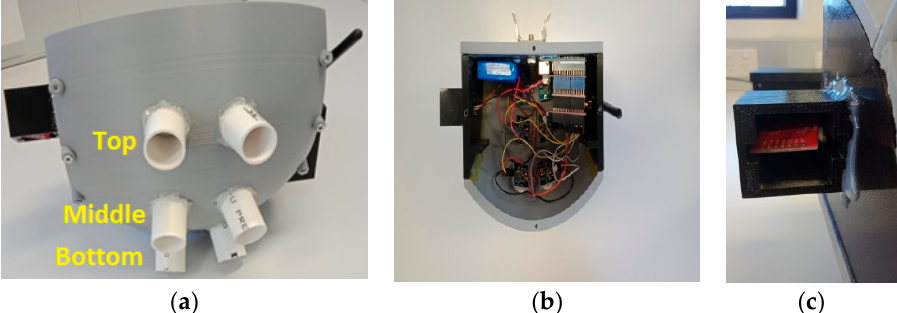
Figure 4. ( a ) Designed mould for accommodating the PIR sensors and other electronic devices and ( b ) internals of the system, ( c ) mould for the environmental combo sensor.